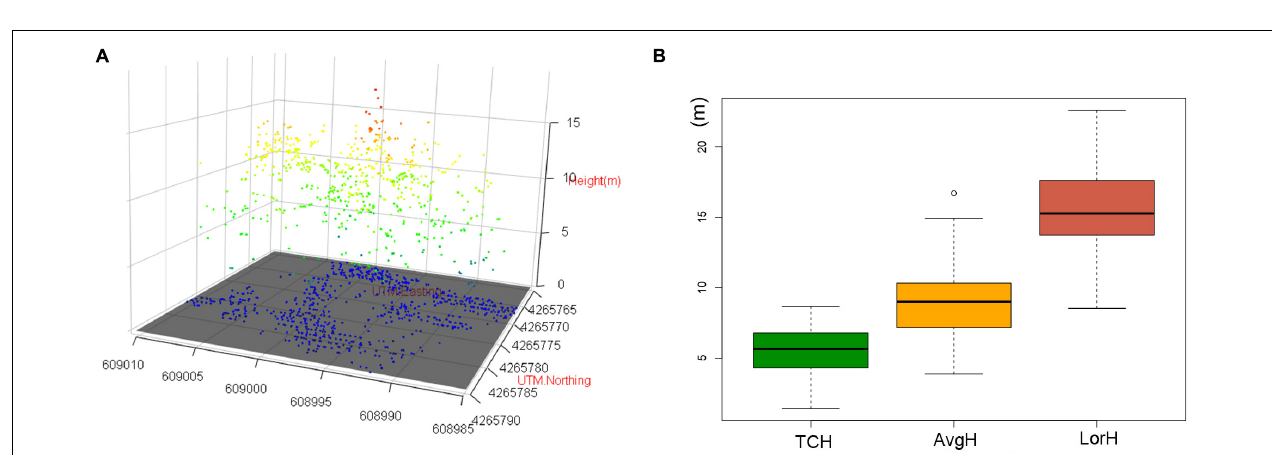
Frontiers in Plant Science |